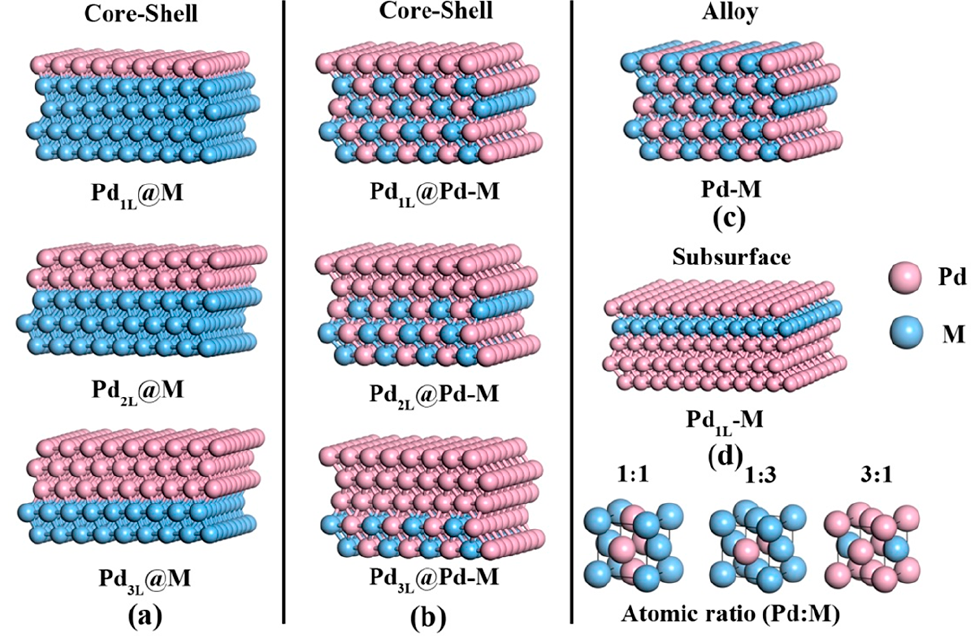
Figure 10. Models for the surface structures: ( a ) core − shell with Pd − M, ( b ) core − shell with a Pd alloy, ( c ) alloy, and ( d ) subsurface. Reprinted with permission from [106].